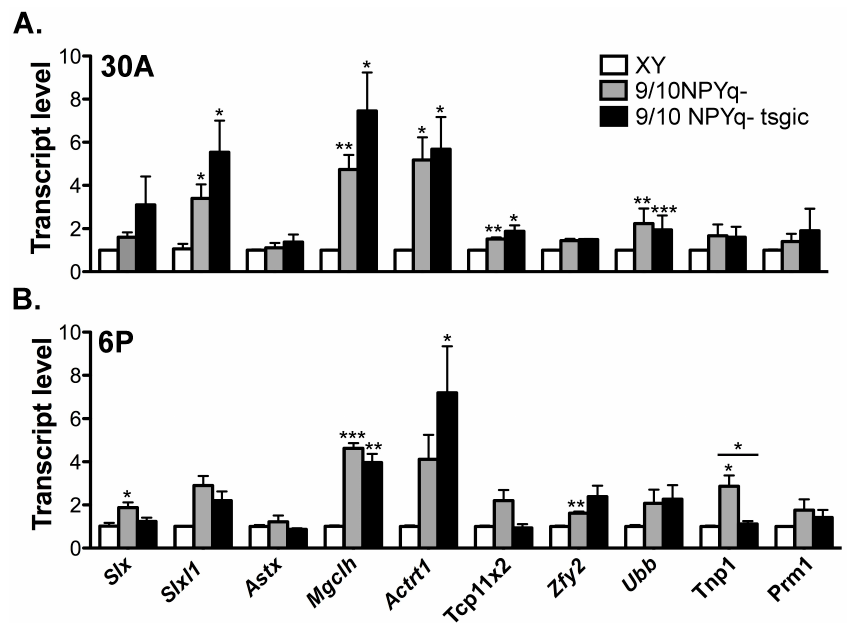
Figure 5. Addition of the Flag-Sly transgene to males with NPYq deletions does not rescue X-Y gene upregulation . Gene expression in testes from NPYq-deficient mice without (9/10NPYq-) and with (9/10NPYq- tsgic) the Flag-Sly transgene was obtained by real-time RT-PCR with Actb as a loading control and normalized to wild-type XY controls. Two transgenic lines were analyzed: line 30A carrying the Sly1 transgene ( A ) and line 6P carrying both the Sly1 and Sly2 transgene ( B ). NPYq- deficient mice without the transgenes were negative siblings of transgenics. The graphs are mean ± SEM with n = 3. Statistical significance ( t -test): * < 0.05; ** < 0.01; *** < 0.001, in comparison with NPYq- deficient mice with XY; the difference between transgenics and their negative siblings is marked with a horizontal lane above the relevant graph pair. Primer sequences are shown in Table S2.